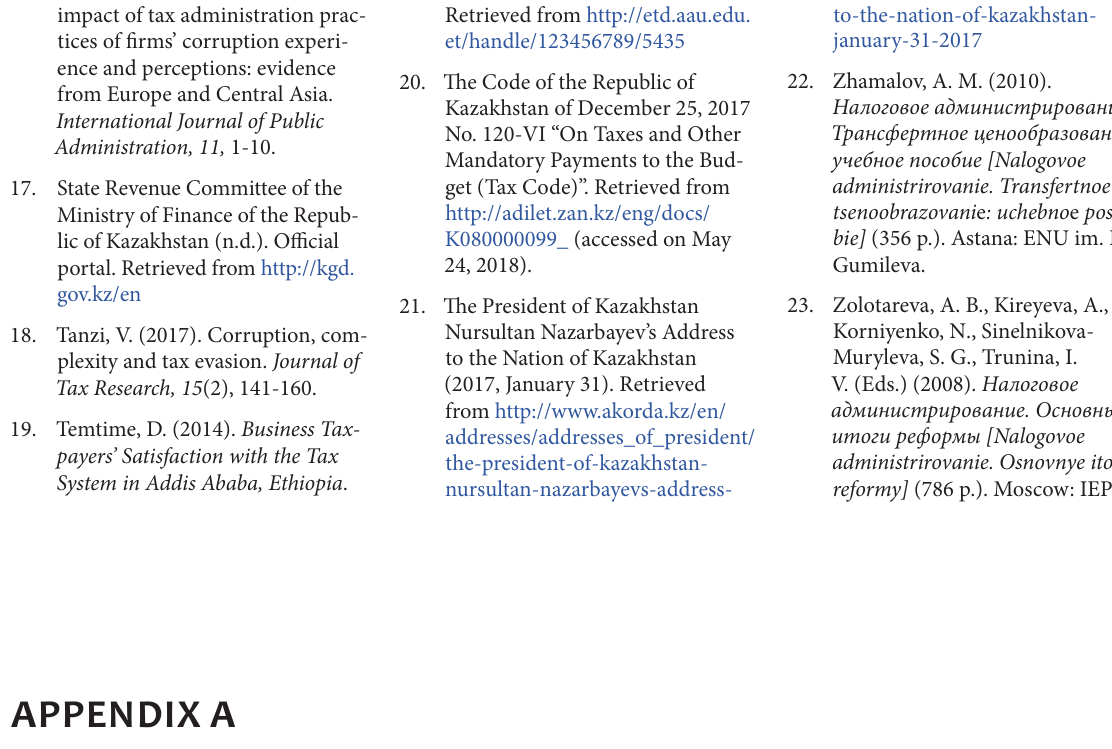
Table A1. Correlation matrix of indicators of the regression model of the effectiveness of tax administration